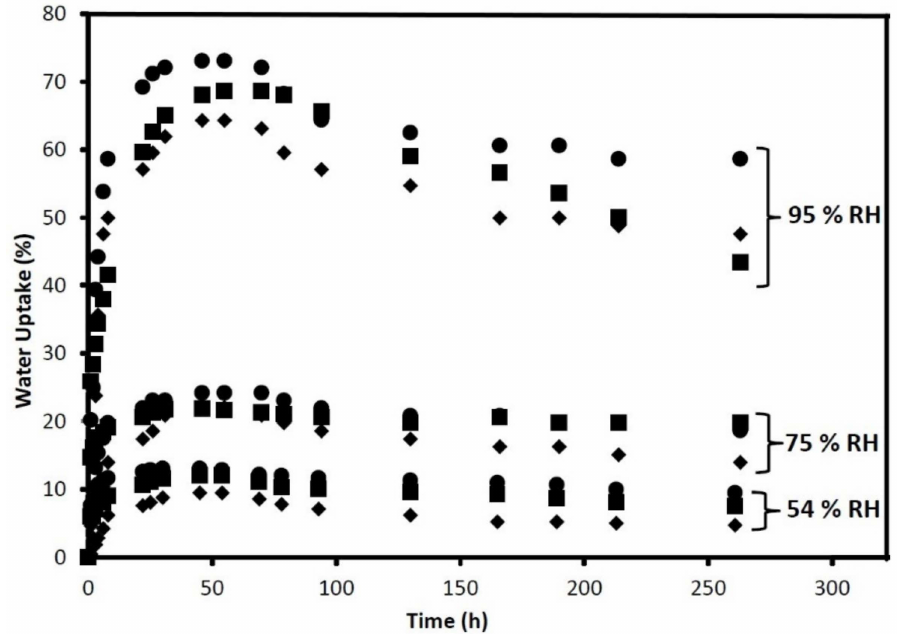
Figure 18. Water uptake trend through time considering the relative humidity (RH) at 20 ◦ C for potato, pea, and corn TPS with CNC 5 wt %. Reproduced with permission from Carbohydr. Polym. , 157 , Montero et al., Effect of Nanocellulose as a Filler on Biodegradable Thermoplastic Starch Films from Tuber, Cereal, and Legume, 1094–1104, 2017